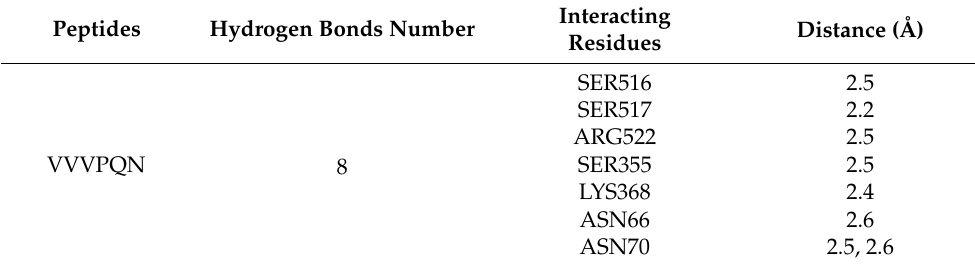
Figure 7. Molecular docking between ACE (PDB: 1O8A) and VVVPQN. Table 3. Interactions between ACE and VVVPQN from the molecular docking simulation. Peptides Hydrogen Bonds Number